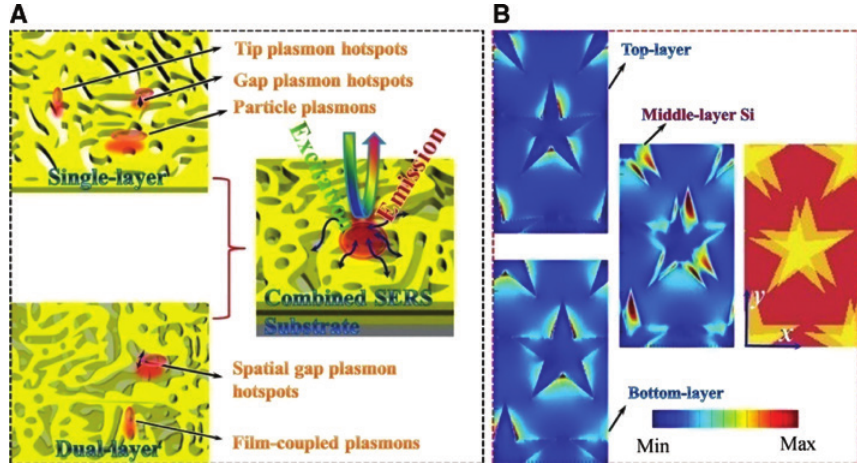
Figure 9: Mechanism discussion of the film buffered dual-layer plasmonic clusters. (A) Schematic of the potential contributions for the enhanced surface-enhanced Raman scattering (SERS). The combined SERS substrate is the efficient cooperation between the multiple plasmon modes and the tip, gap based plasmon hotspots, the film-coupled plasmonic resonances, and other plasmon hotspots by the spatially distributed and displaced clusters and/or their sharp edges and corners. (B) Calculated local electric field distributions in the top and bottom Au clusters, and the middle Si layer. The schematic of the ideal model is designed as dual-film Au star-shape clusters sandwiched by a Si layer. The top and the bottom clusters have a spatial